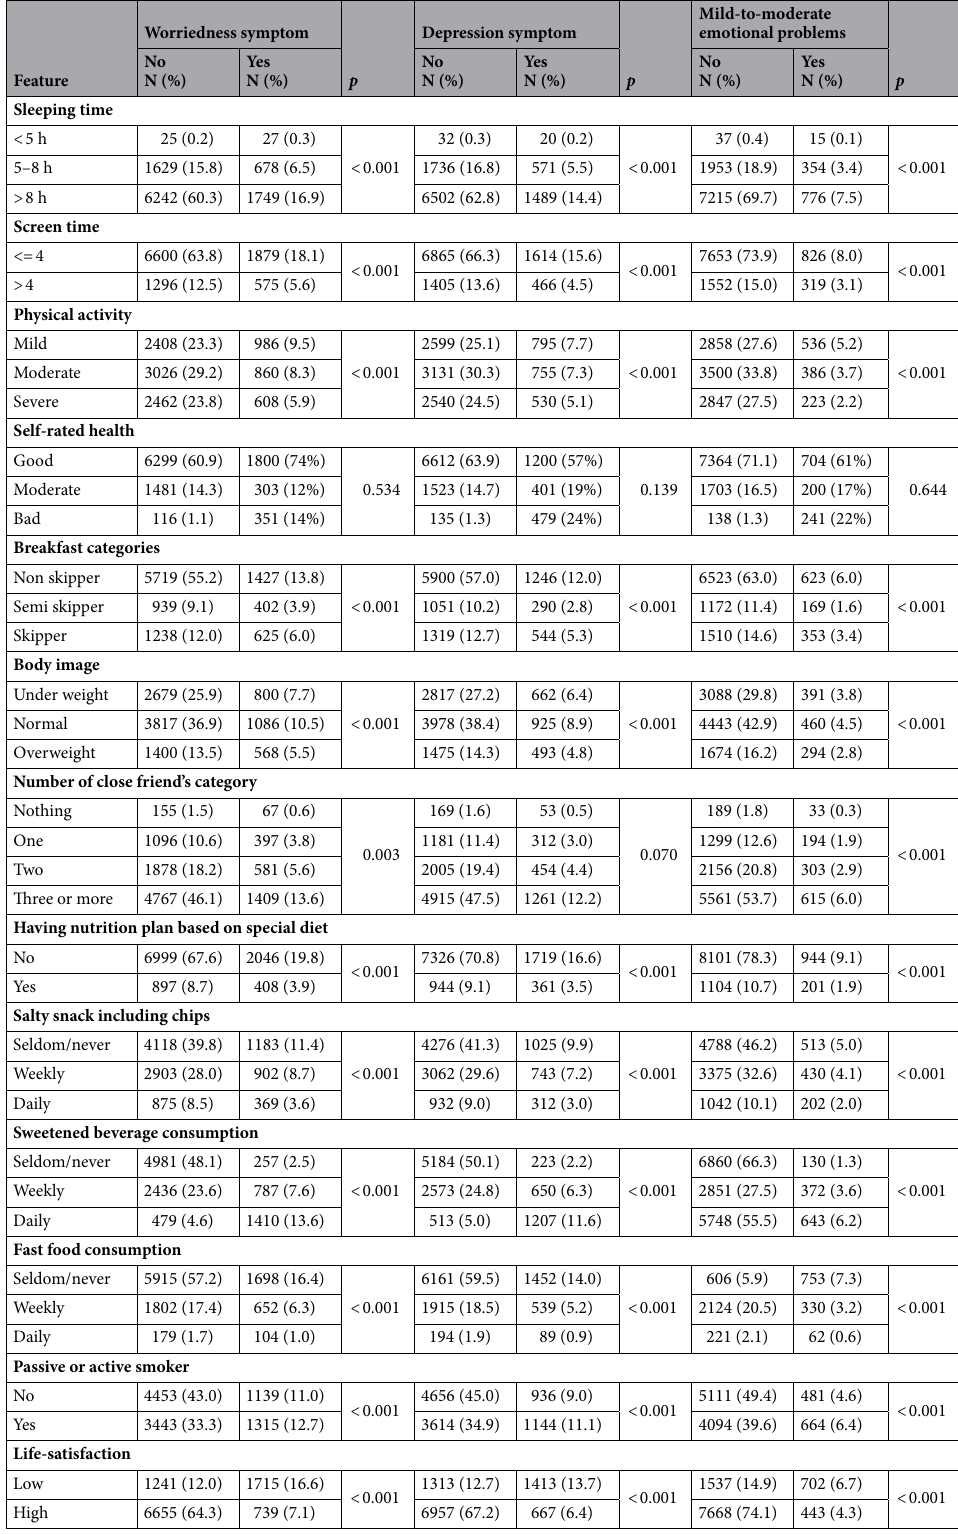
Table 2. Lifestyle and health-related characteristics of participants: the CASPIAN-IV study. N number of people who are in each